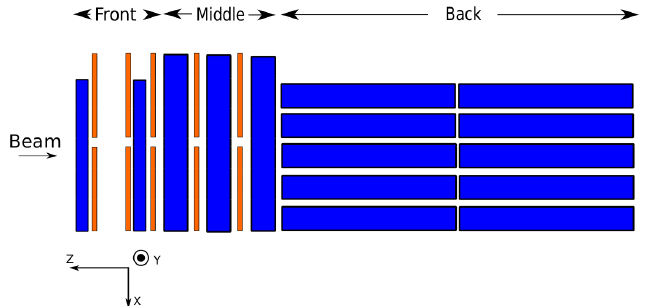
Figure 5. Top view of the TIC prototype: the blue modules represent the trays containing the crystals; the silicon sensors are in orange (from